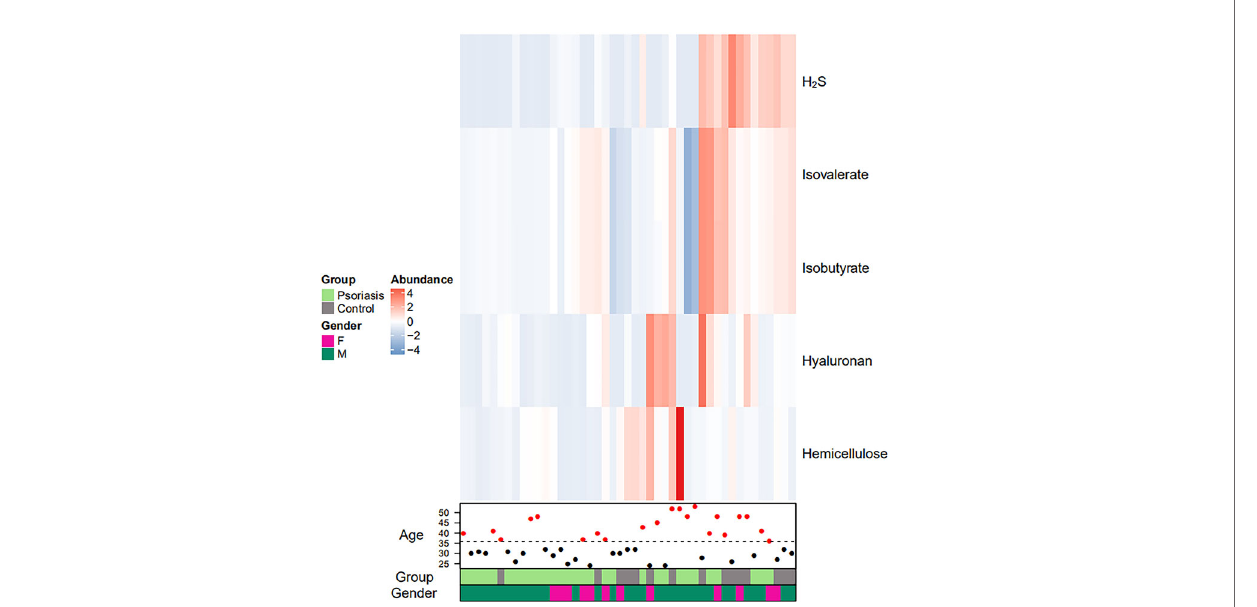
FIGURE 6 | Faecal metabolic heatmap of samples from psoriasis patients. Hierarchical clustering showing the 5 signi fi cantly differentially abundant metabolites between the 2 groups (increased and decreased levels of metabolites are indicated by red and blue, respectively). The lines indicate speci fi c metabolites, and the columns represent the